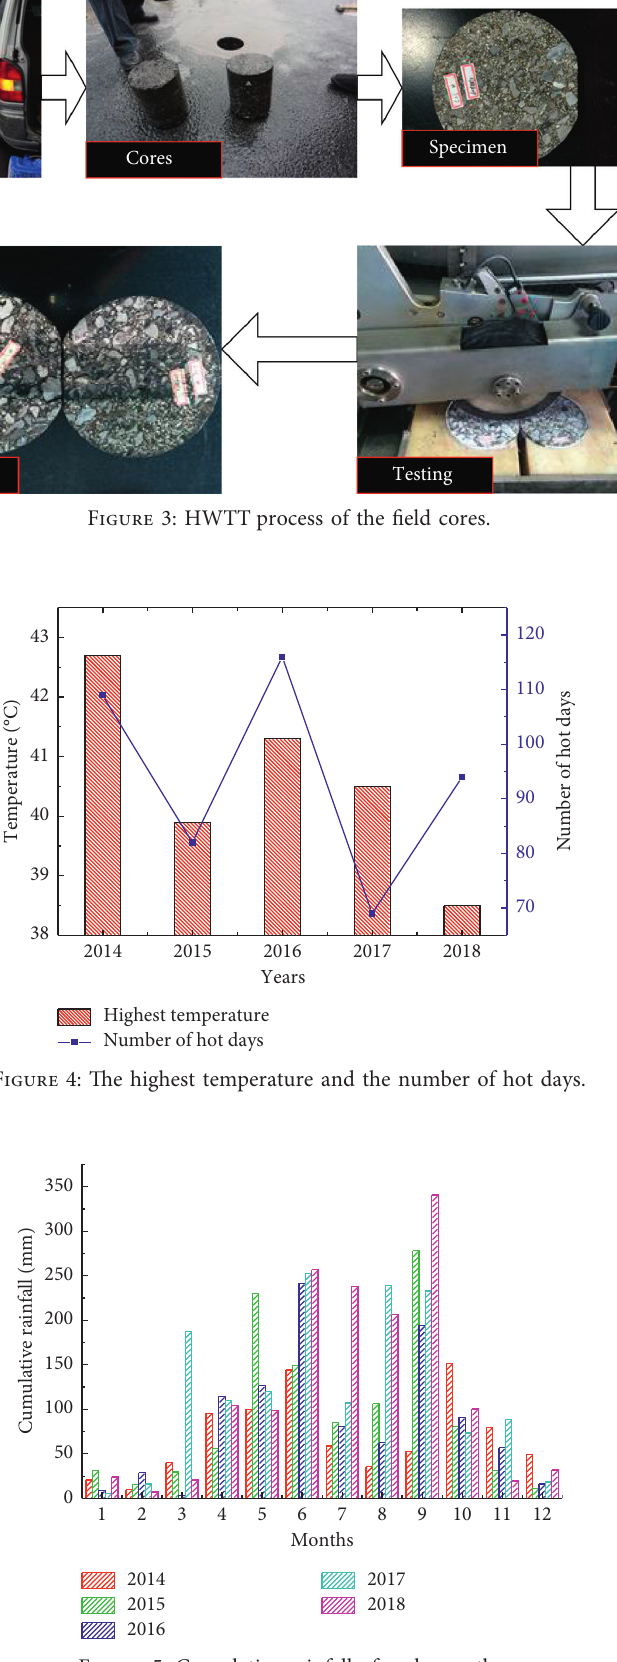
Figure 5: Cumulative rainfall of each